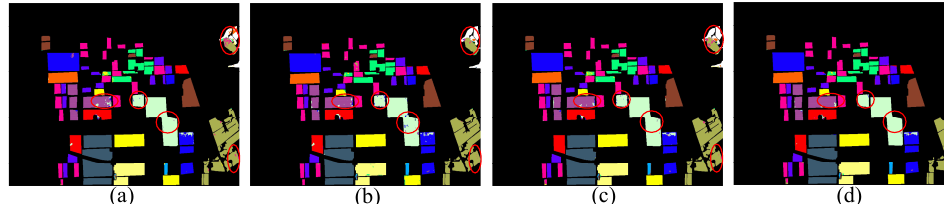
Figure 22. Classification maps of AIRSAR Flevoland dataset with different classification methods.